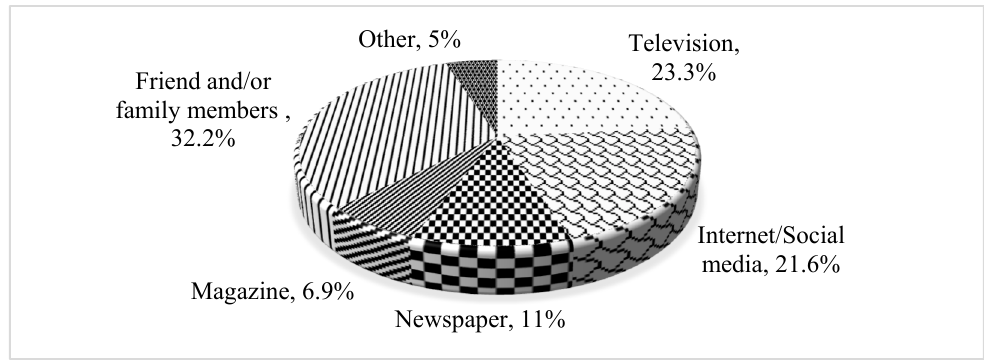
Figure 5. The source of information about the locally-produced rice. Source: Field survey, 2017.